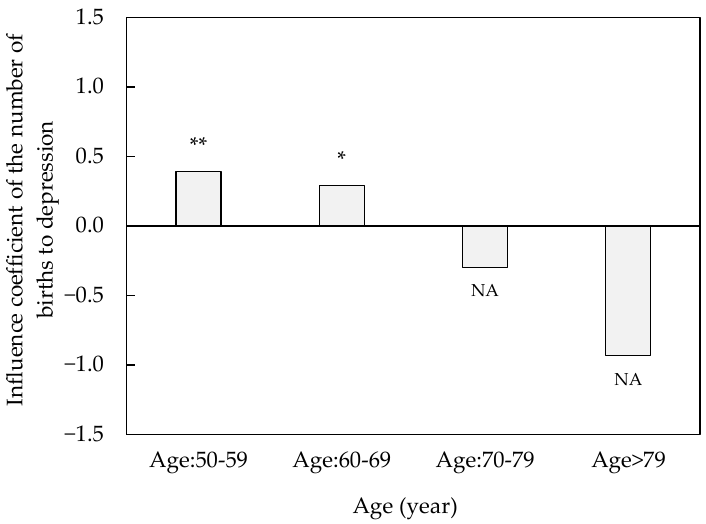
Figure 2. Number of births and depression in different age groups. Notes: * p < 0.05, ** p < 0.01; NA stands for p > 0.1.